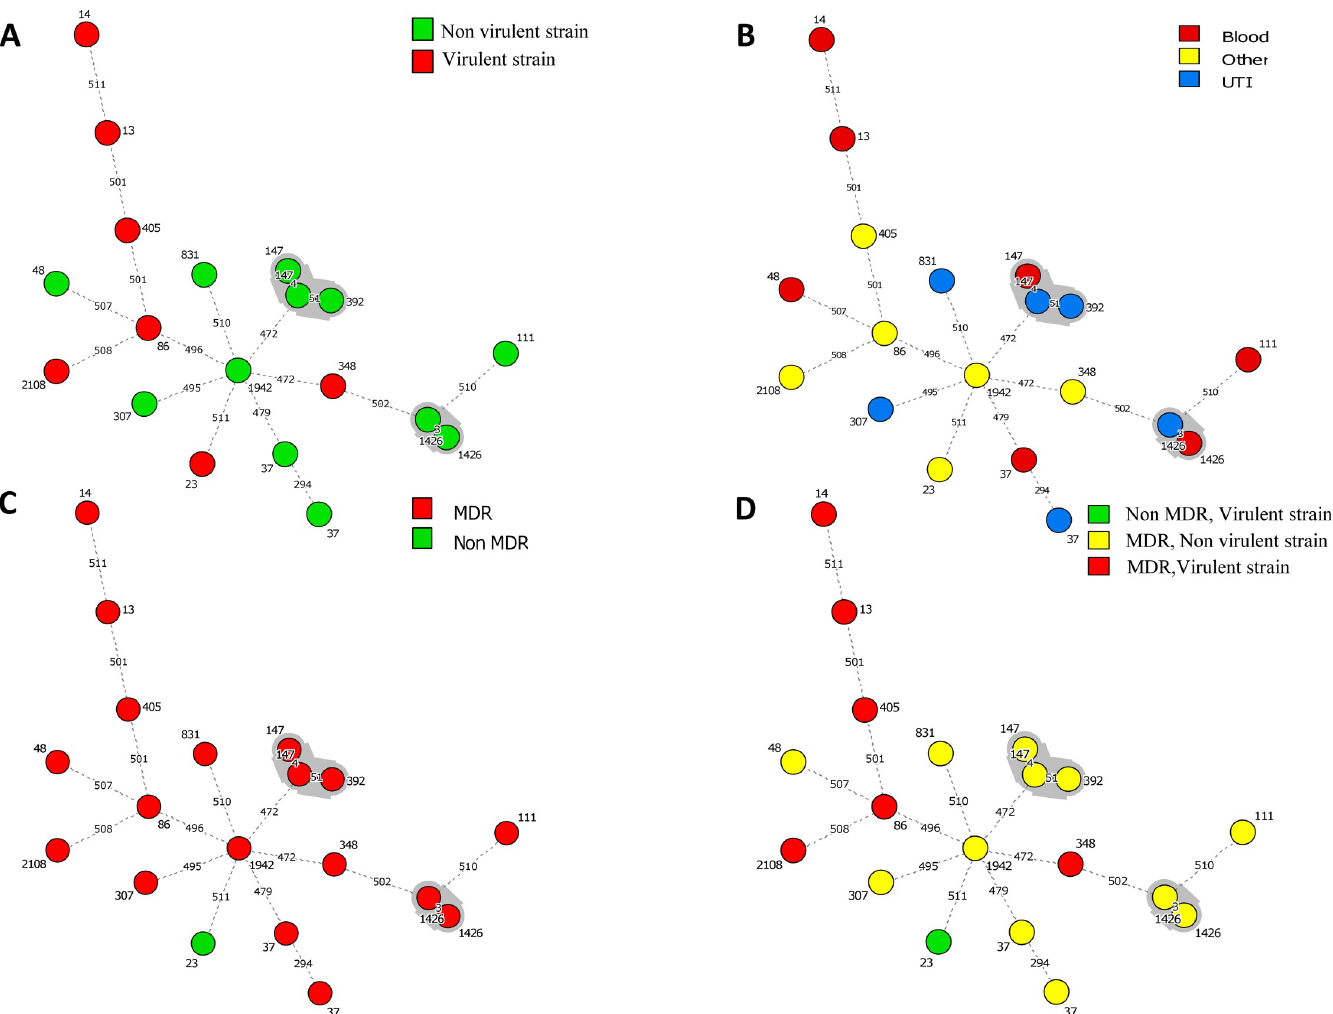
Fig 2. Minimum Spanning Trees (MSTs) analysis showing the distribution of MDR profiles, virulence factors, and infection types among 19 isolates of K . pneumoniae based on 632 allelic profiles of cgMLST. Each node within the tree represents a single isolate with a unique genotype. Selected nodes are labeled with corresponding STs. The length of branches linked two nodes indicates the number of allelic mismatches in a pairwise comparison. Long branches are marked with dashed lines. Thick lines correspond to a short branch with less than 100 allelic mismatches. The grey zones surrounding nodes indicate that they belong to the same clonal group. Four MST graphs were generated separately based on the following associations. A: MST versus virulence genes, B: MST versus infection types, C: MST versus resistance genes profiles, D: MST versus MDR and virulence classes. MDR: Multi-Drug Resistance. UTI: Urinary Tract Infection.